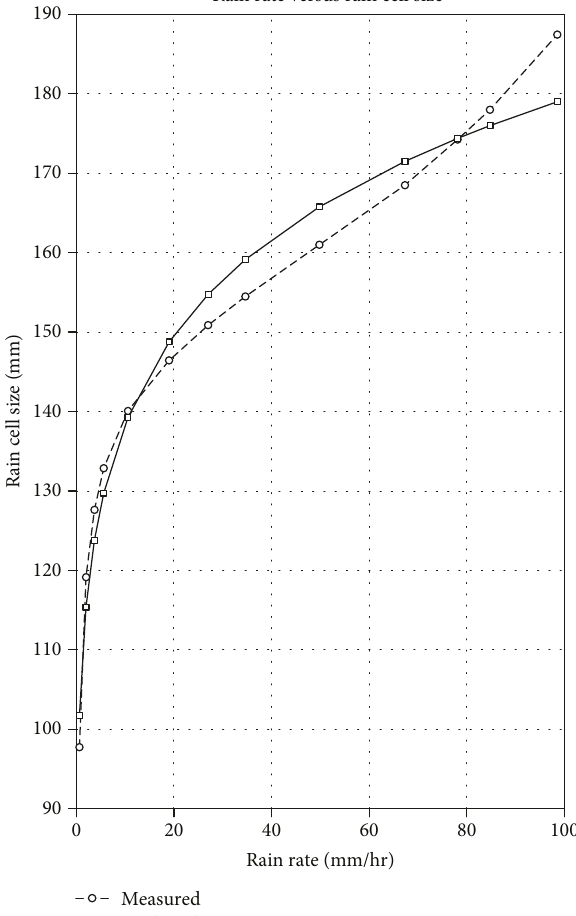
Figure 4: Cumulative distribution of rain attenuation compared with ITU-R P.530-16 for various integration times [34]. Figure 5: Distribution of rain cell size against rain rate [24]. Table 3: Observed rain rate and calculated rain cell